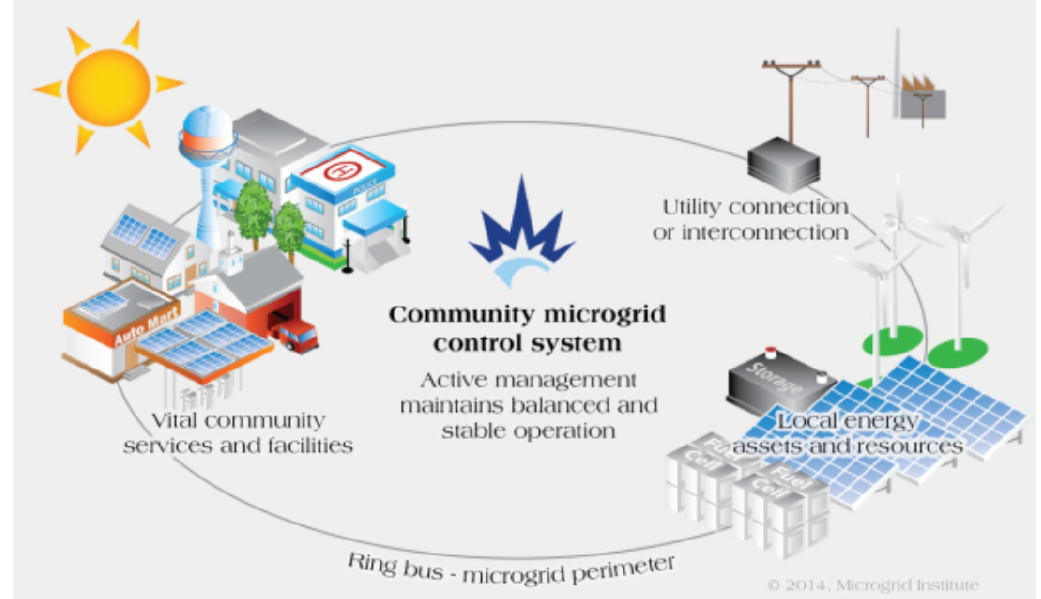
Figure 1. Microgrid Model. Reprint from [2], Microgrid Institute,